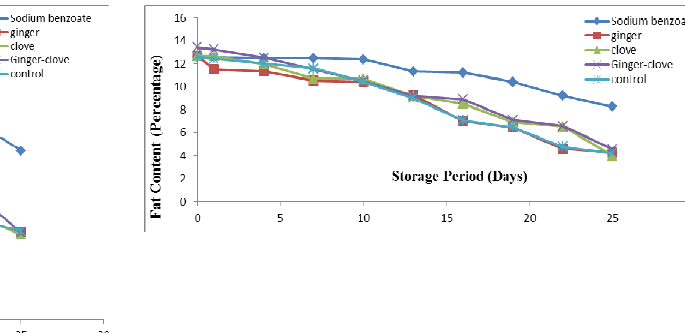
Fig. 12. Effects of different treatments on the protein content of soymilk samples at 5% concentration stored at refrigerated temperature for 25 days